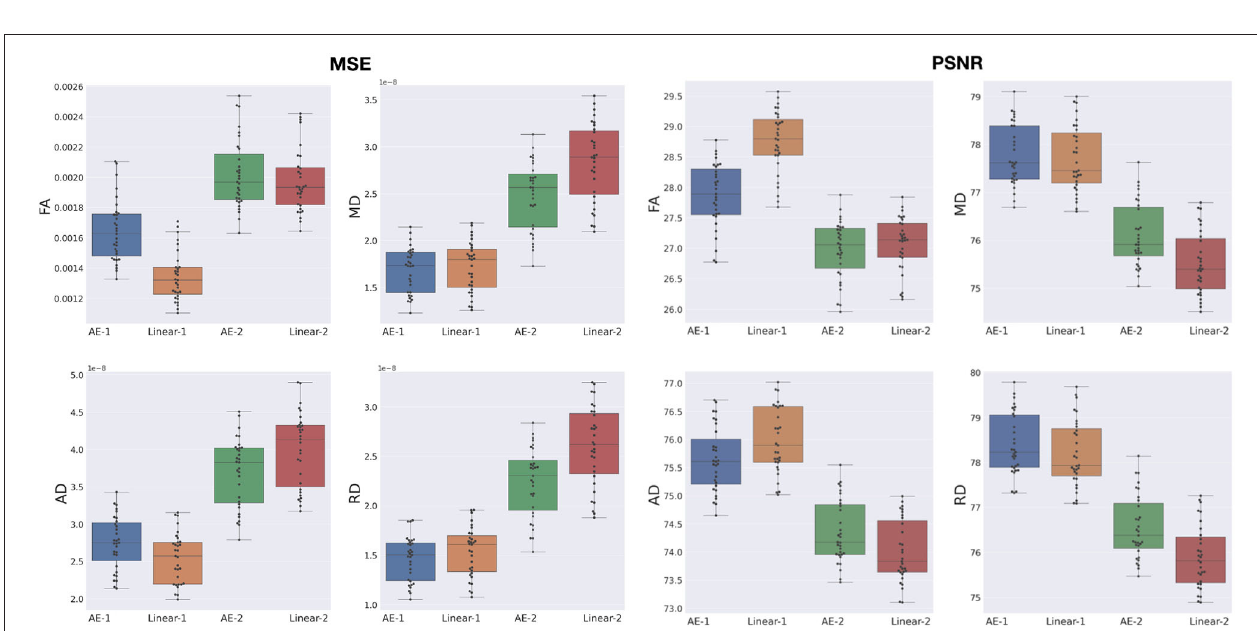
FIGURE 6 | MSE and peak signal-to-noise ratio (PSNR) between the best baseline (Linear) and the autoencoder (AE) enhancement for whole-brain diffusion tensor maps, when removing and synthesizing/interpolating one or two slices. FA, Fractional Anisotropy; MD, Mean Diffusivity; AD, Axial Diffusivity; RD, Radial Diffusivity.